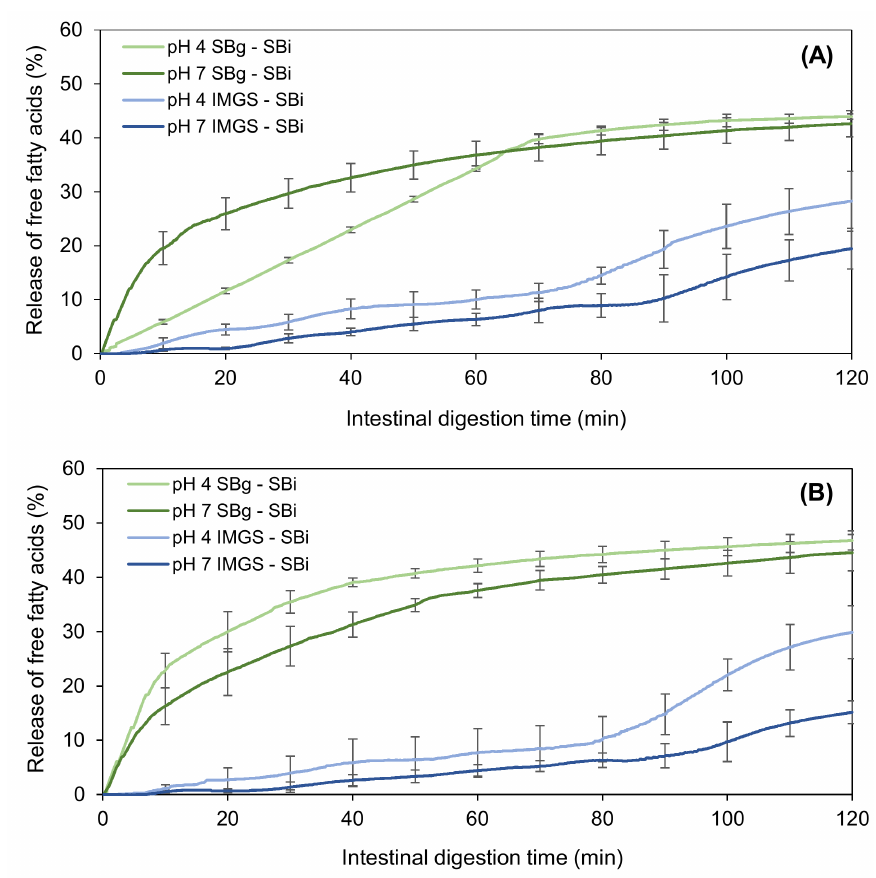
Figure 7. Kinetics of in vitro intestinal lipolysis using the systems IMGS–SBi and SBg–SBi for emulsion gels stabilized by WPI and fabricated at 500 bar ( A ) and 1000 bar ( B